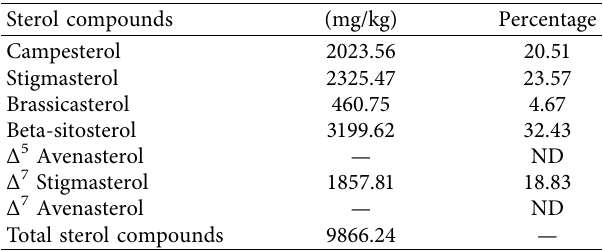
Table 3: Sterol compounds in the methanolic extract of C. dactylon rhizomes.